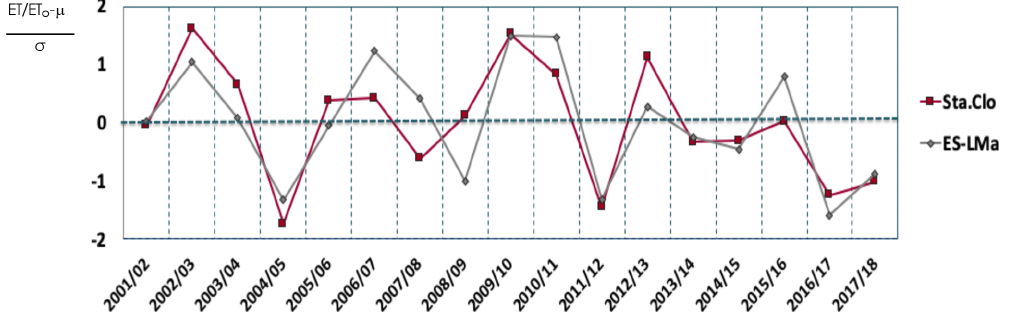
Figure 4. Annual anomalies of relative evapotranspiration at ES-LMa and Sta.Clo experimental sites estimated using the SEBS model from 2001/2002 to